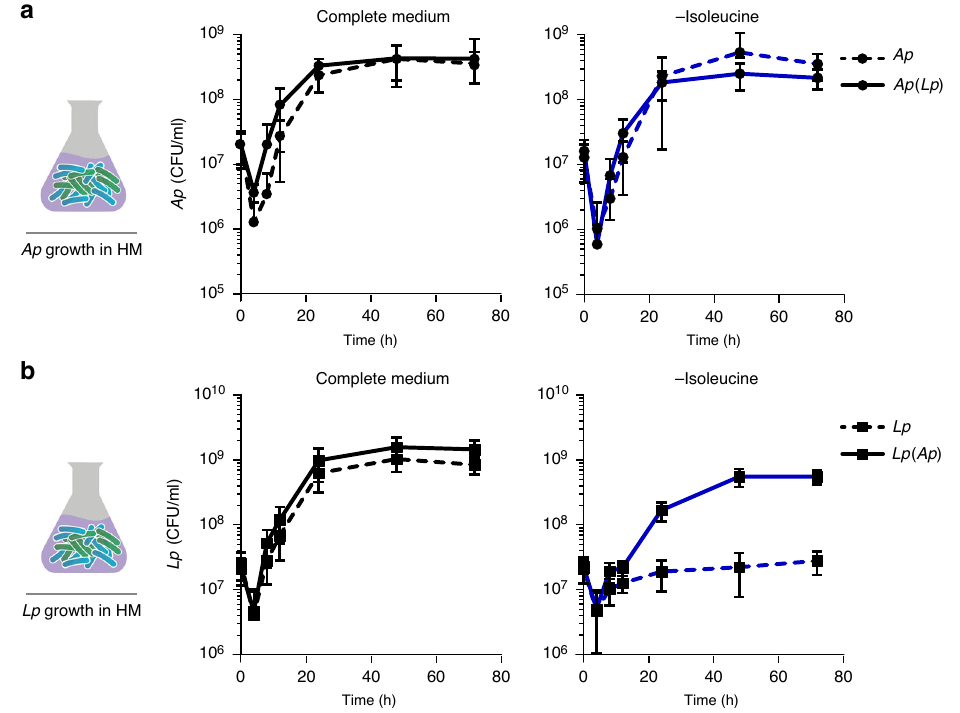
Fig. 2 In vitro growth measurements show that Lp can overcome its auxotrophy for Ile when co-cultured with Ap . In vitro growth curves of Ap ( a ) and Lp ( b ) in complete liquid holidic medium (black line) or in liquid medium without Ile (blue line) plotted as CFUs at different time intervals. Data points connected by dashed lines represent the number of CFUs detected in cultures of individual species ( Ap or Lp ) and the data points connected by continuous lines, the number of Ap (labelled as Ap ( Lp )) or Lp (labelled as Lp ( Ap )) CFUs in co-culture conditions. The number of CFUs per ml of culture was determined by cultivating liquid culture samples in selective media at the indicated time points. For each condition, seven independent bacterial cultures were sampled at 0 h, 24 h, 48 h and 72 h. Additionally, four cultures were sampled at 4 h, 8 h and 16 h. Each data point represents the mean CFUs from independent bacterial cultures ( n = 7 for 0, 24, 48 and 72 h; n = 4, 8 and 16 h) and the error bars the standard deviation (s.d.). Source data are provided as Source data fi